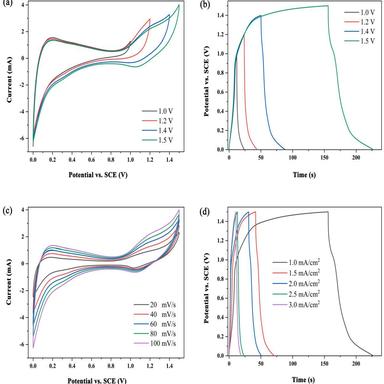
Electrochemical performance of CdSe (40 min) symmetric solid supercapacitor (a) CV curves at different potential windows at a scan rate of 100 mV/s, (b) GCD curves at different potential windows at current density of 1 mA/cm2 , (c) CV curves at different scan rates with 1.5 V, and (b) GCD curves at different current densities with 1.5 V.